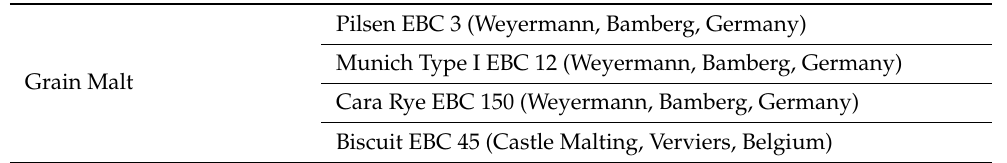
Table 1. Main Brewing raw materials used in the elaboration of craft beers.